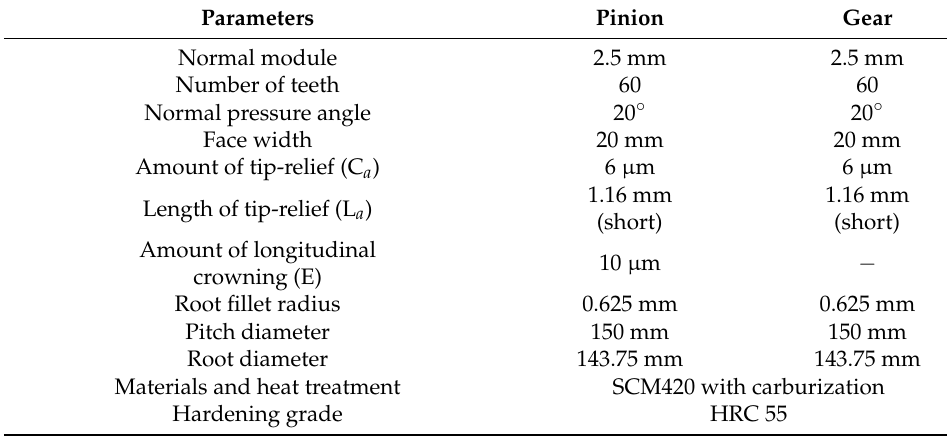
Figure 1. Gear modification parameters. Table 1. Design parameters of the spur gear set.